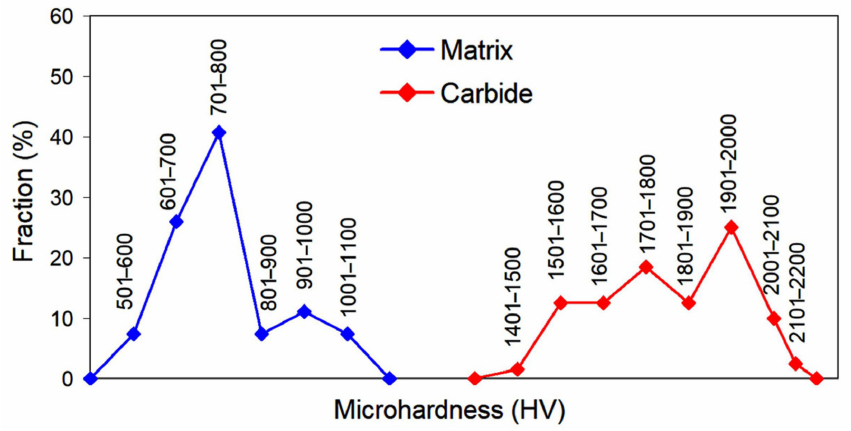
Figure 6. The coating microhardness: distribution of the values for the matrix and carbide particles.